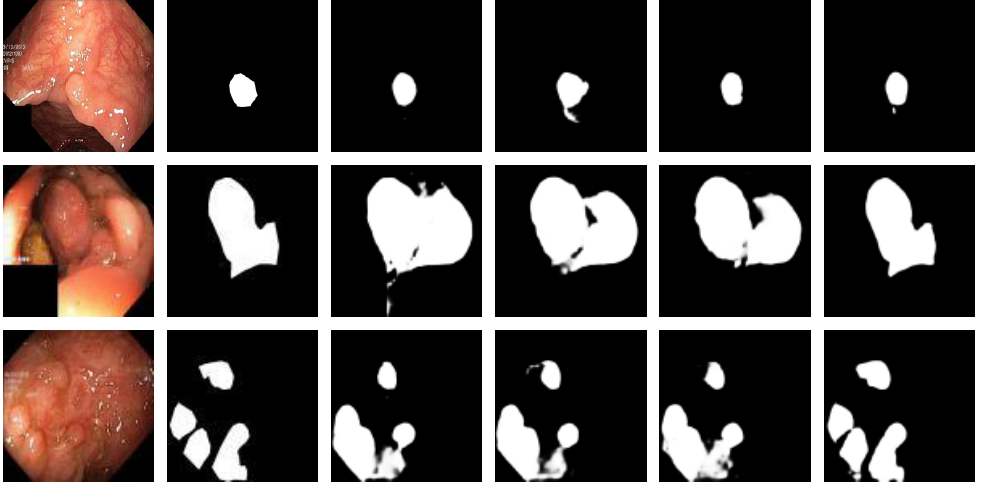
Figure 7. Comparison of segmentation results with and without CEM from the Kvasir-SEG dataset. The image, the mask, and the segmentation results of N/CEM, ASPP, CBAM, and the proposed model are presented from left to right.